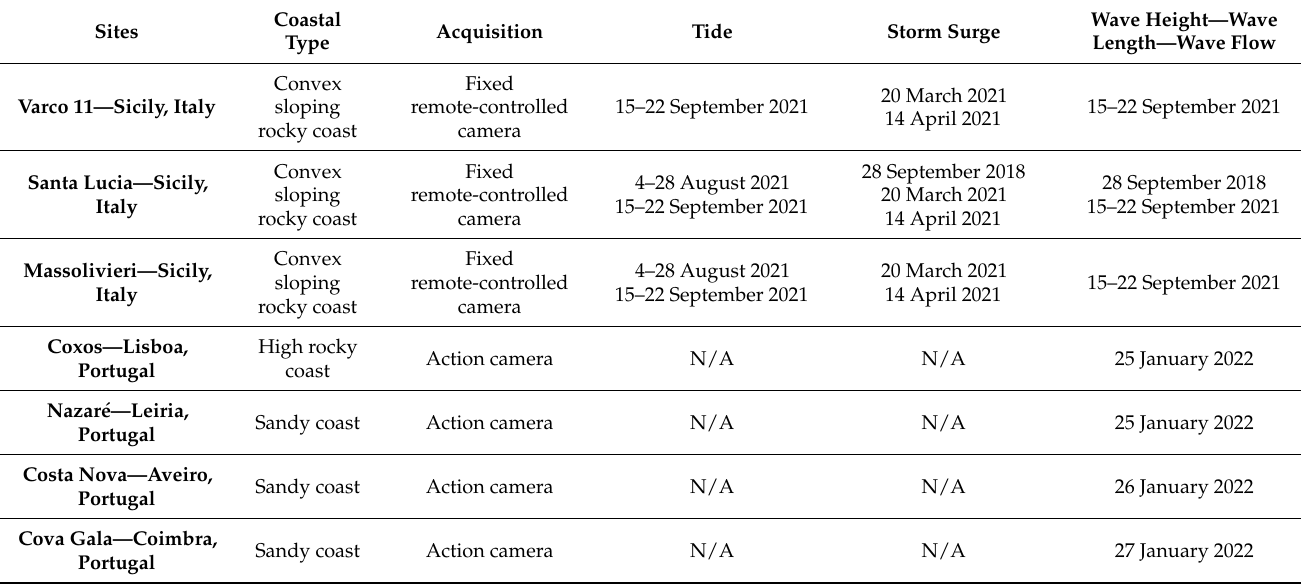
Table 1. Datasets of Mediterranean and Atlantic video records used to assess tide phases, surge, and physical wave